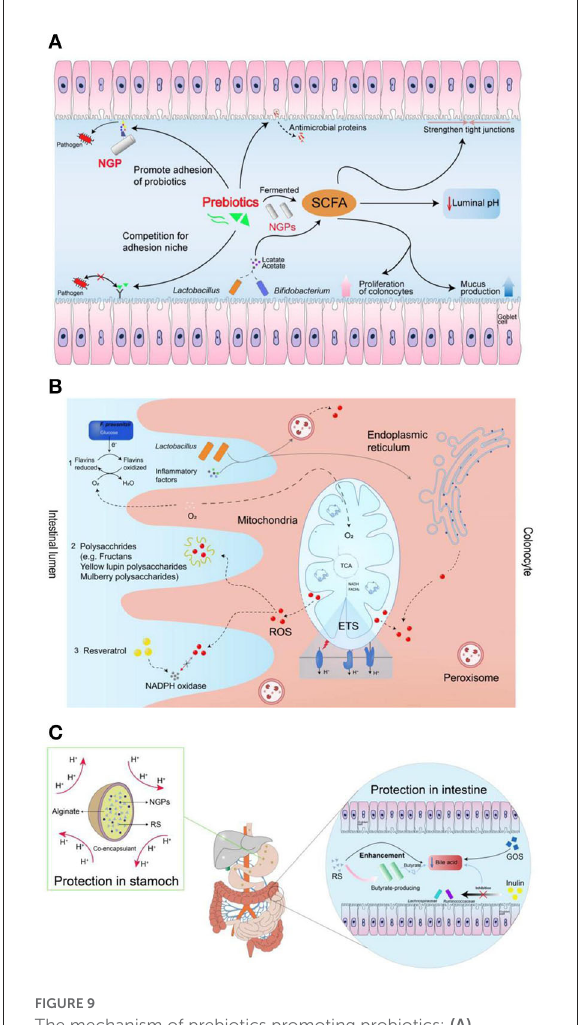
FIGURE9 The mechanism of prebiotics promoting probiotics: (A) prebiotics for enhancing the functions of probiotics; (B) prebiotics for enhancing the resistance of probiotics to reactive oxygen species; (C) protective functions of prebiotics by maintaining the viability of probiotics during gastrointestinal transit